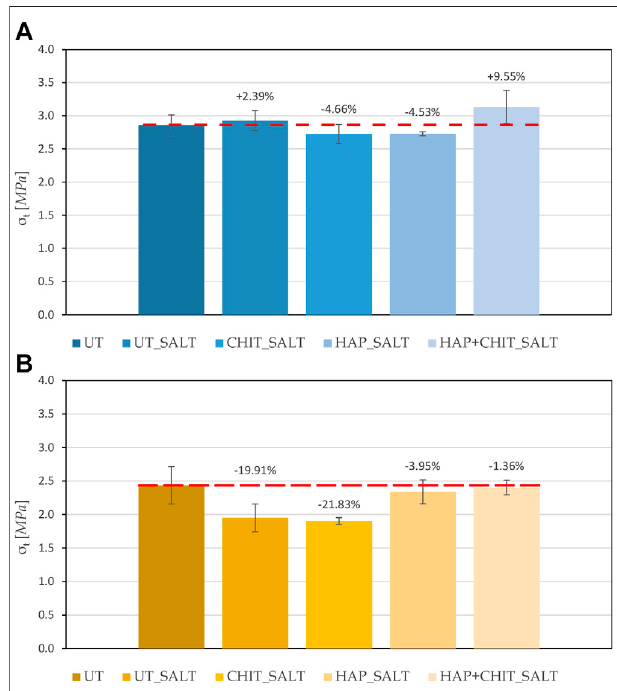
FIGURE 8 | Tensile strength of the cylindrical samples, obtained with splitting test, after the crystallization test and compared with the UT sample, for: (A) Lecce stone and (B) Globigerina limestone. The dotted line indicates the initial value of the UT reference (2.86 MPa for L and 2.44 MPa for G).